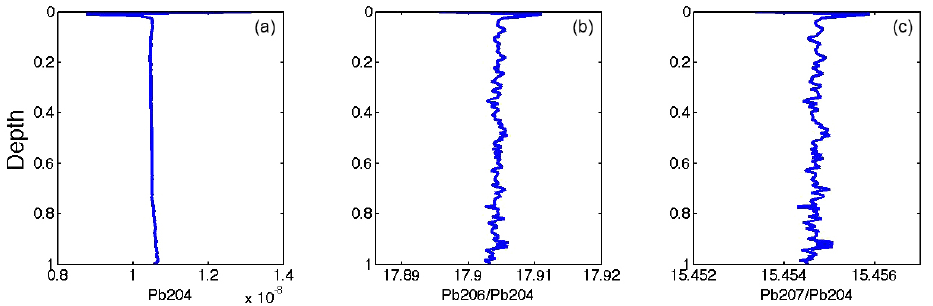
Figure 7. Radial profiles of different Pb isotopes taken at the end of the calculation (present day, after 3.6BY of calculation time). The vertical axes indicate the non-dimensional depth running from the surface (0) to the core–mantle boundary (1). The left diagram shows the radial average (mean) concentration of 204 Pb in moles per kilogram. The middle two diagrams show the radial average molar ratios of 206 Pb / 204 Pb and 207 Pb / 204 Pb.